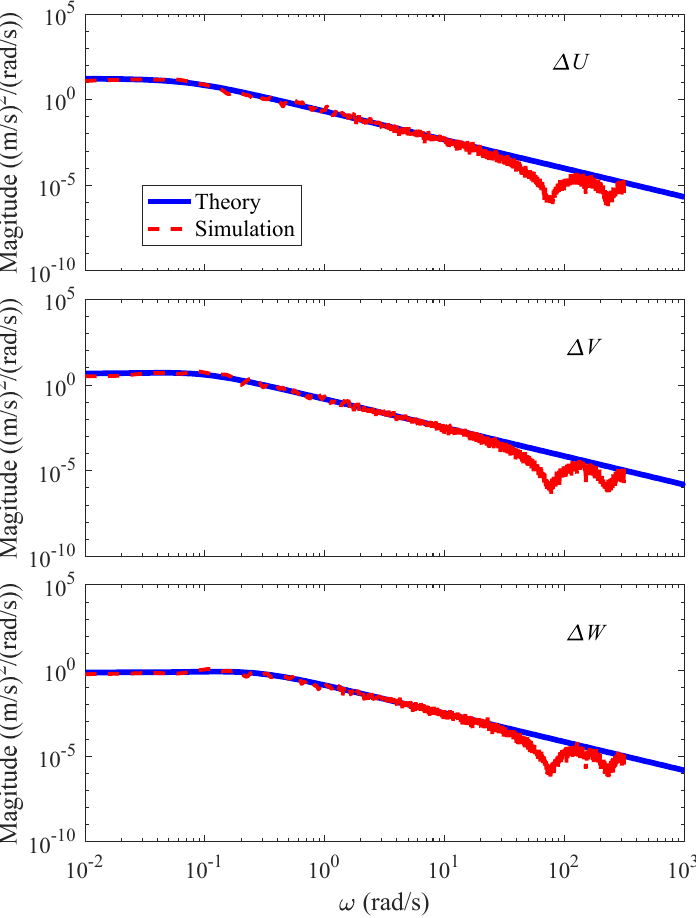
Figure 5. Comparison between simulated and theoretical turbulence spectra at fuselage.